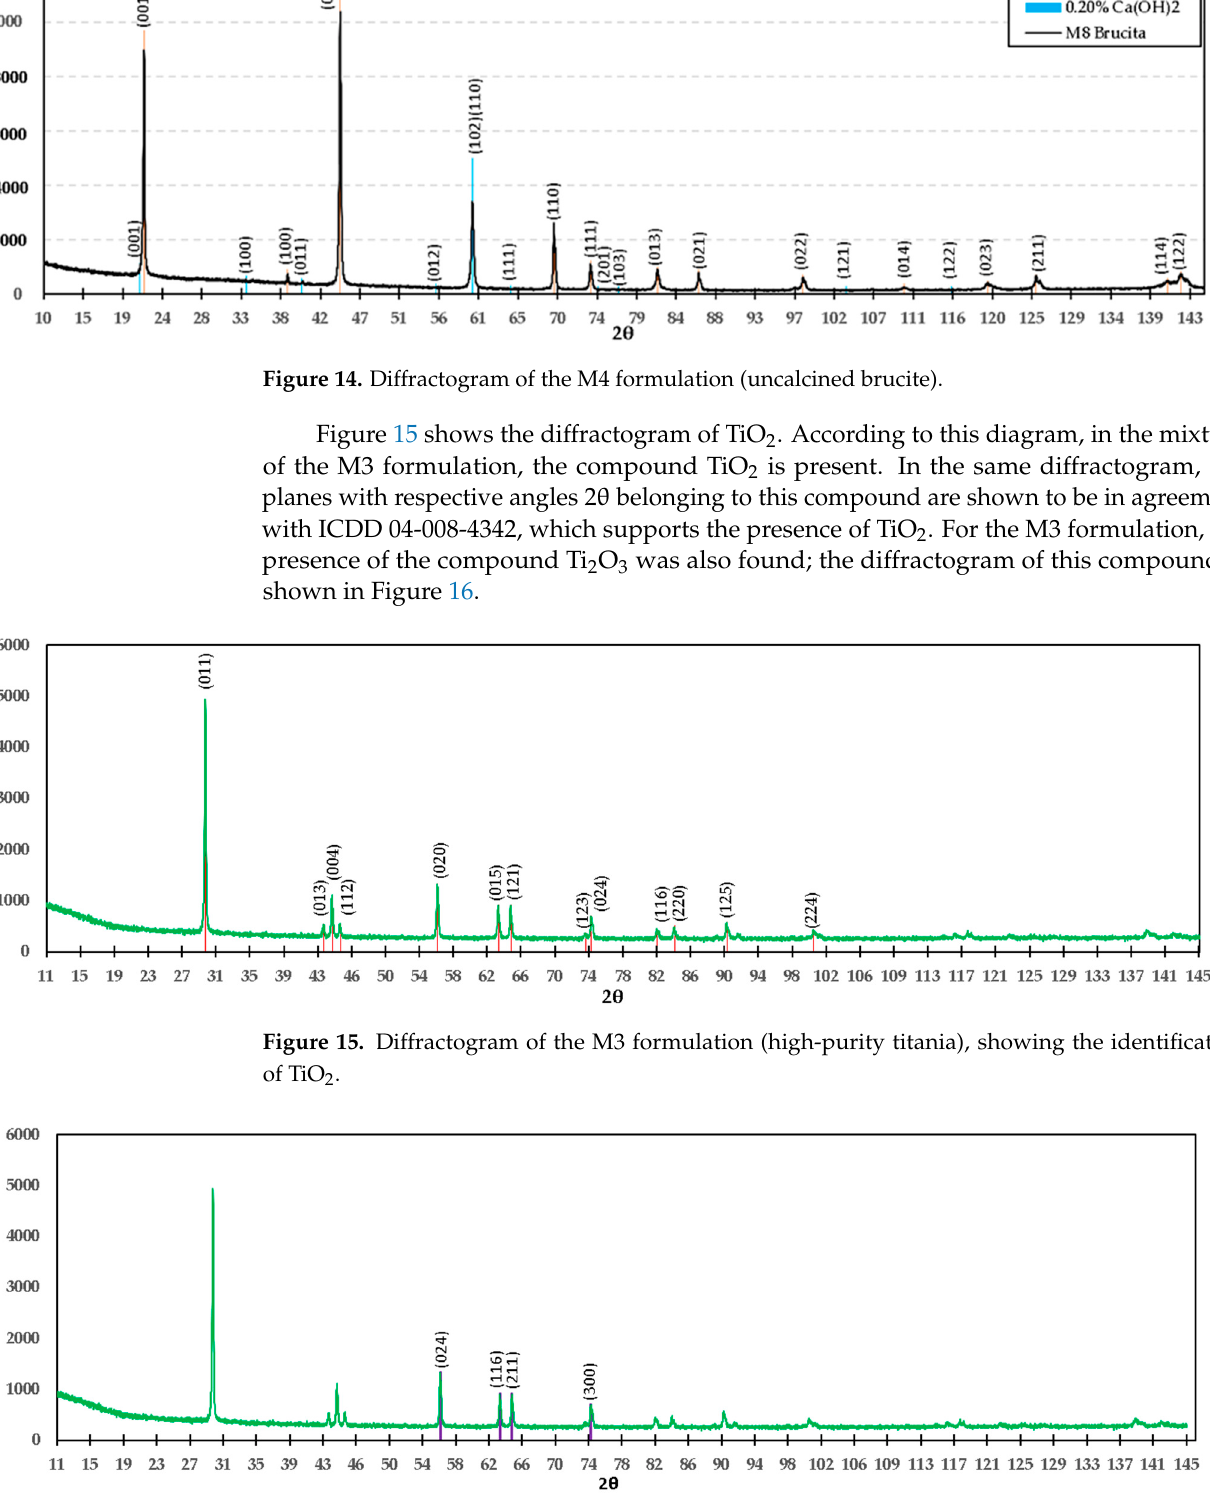
Figure 14. Diffractogram of the M4 formulation (uncalcined brucite).